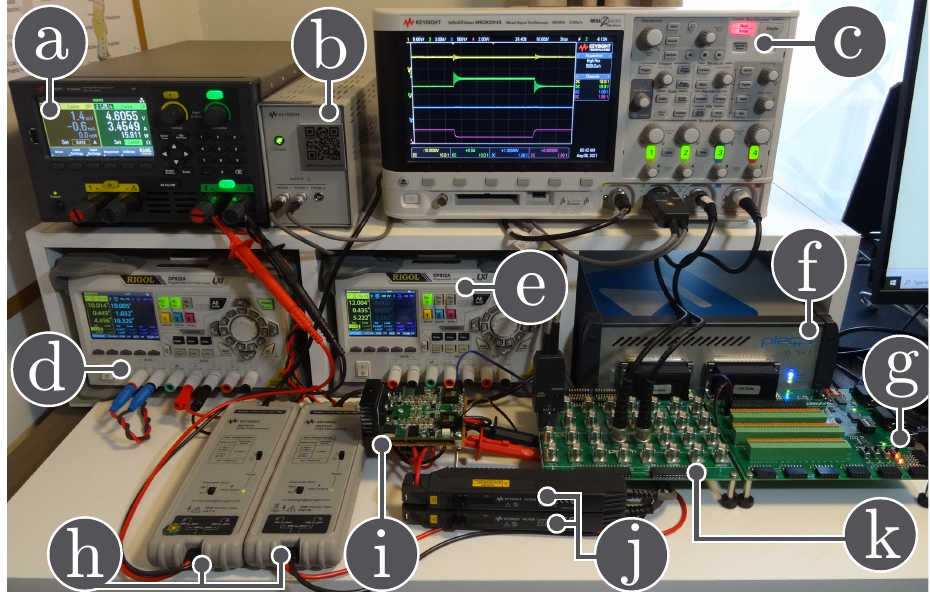
Figure 2. Experimental setup: ( a ) dc electronic load in constant resistance mode, ( b ) power supply for the current probes, ( c ) oscilloscope, ( d ) input dc power supply, ( e ) auxiliary power supply, ( f ) PLECS RT-box, ( g ) digital breakout board, ( h ) voltage differential probes, ( i ) reconfigurable power converter, ( j ) current probes, ( k ) analog breakout